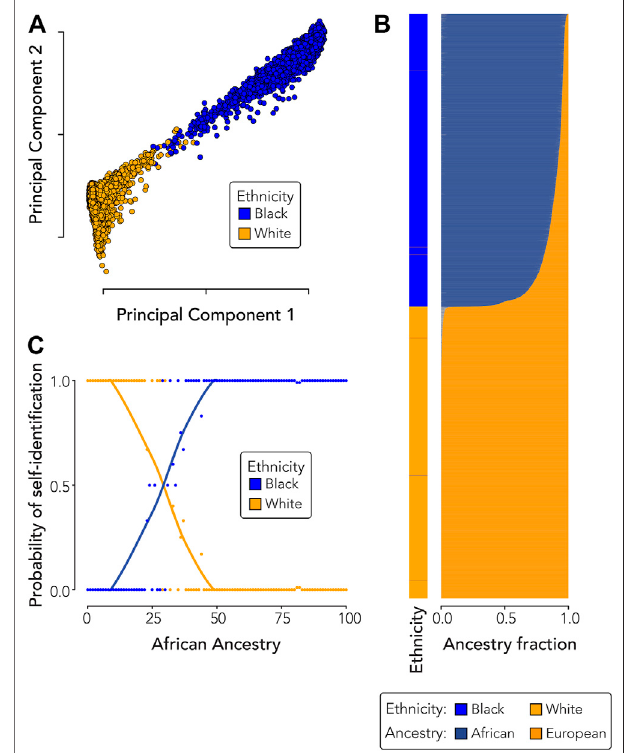
FIGURE 3 | Ethnicity and genetic ancestry. (A) Principal components analysis showing the relationship between participant ethnicity and genetic diversity. (B) Participant ethnicity (left) compared to participant genetic ancestry fractions (right). (C) Probability of participant ethnic self-identity ( y -axis) compared to African genetic ancestry ( x -axis). Dots are color-coded byparticipantethnicityandeachdotshowstheprobabilityofself-identi fi cation as Black or White across one hundred bins of African ancestry. Black and White self-identi fi cation probability trend lines were fi t using loess